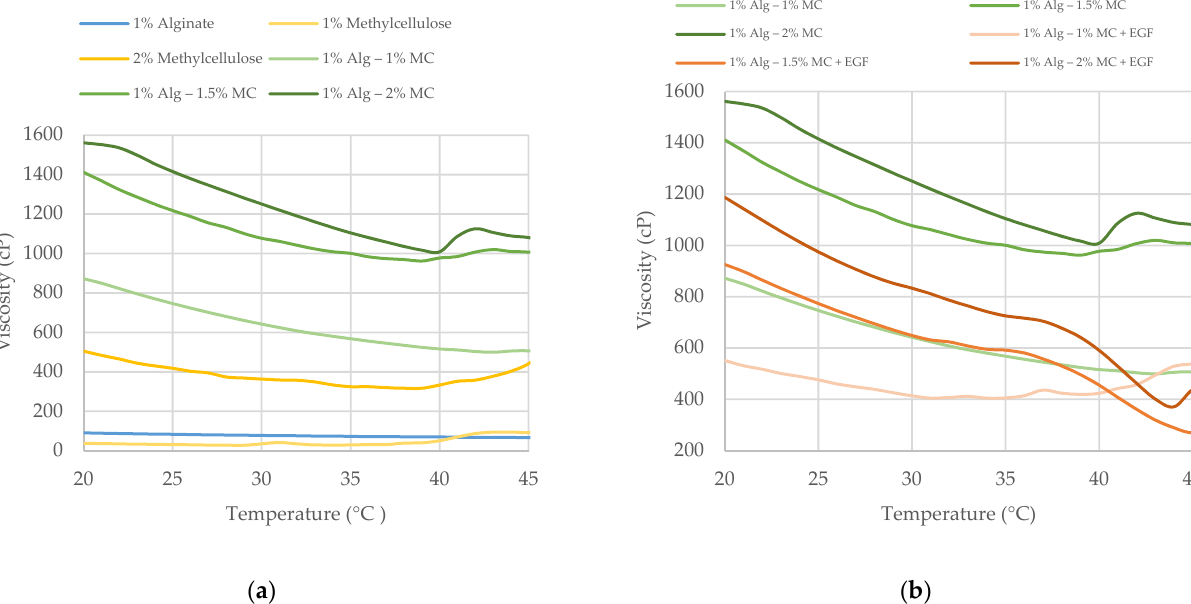
Figure 7. The response of gel systems with varying methylcellulose concentration ( w/v ) as temperature increased by 1 °C per minute: ( a ) Alginate (blue), methylcellulose (yellow), and the resulting mixtures of the two (green); ( b ) The impact of 3.33 mg/mL epidermal growth factor addition (red) on alginate-methylcellulose mixtures (green). Viscosity values were continuously acquired as a function of increasing temperature.